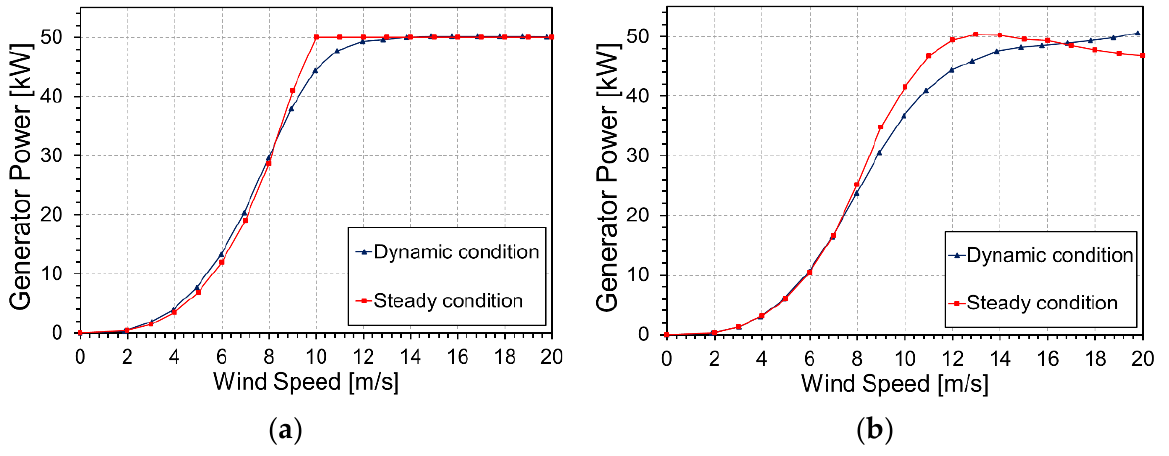
Figure 11. Power curves of the pitch- ( a ) and stall-controlled ( b ) variable speed concept. For the pitch-regulated turbine, especially, there was a tendency to increase power output below rated power, while both the pitch- and stall-regulated turbines